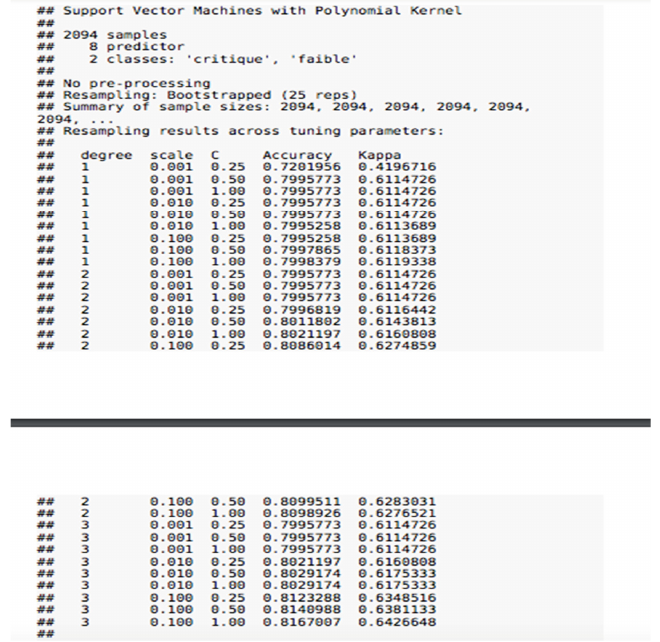
J. Pers. Med. 2021 , 11 , 1117